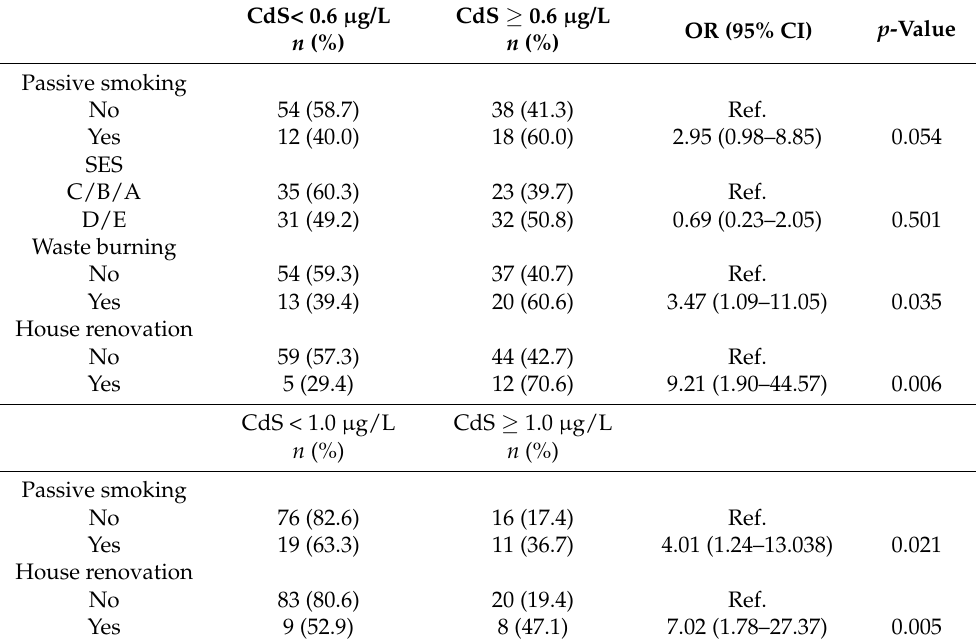
Table 6. Determinants of CdB level above reference values based on χ 2 and MLR. CdS< 0.6 µ